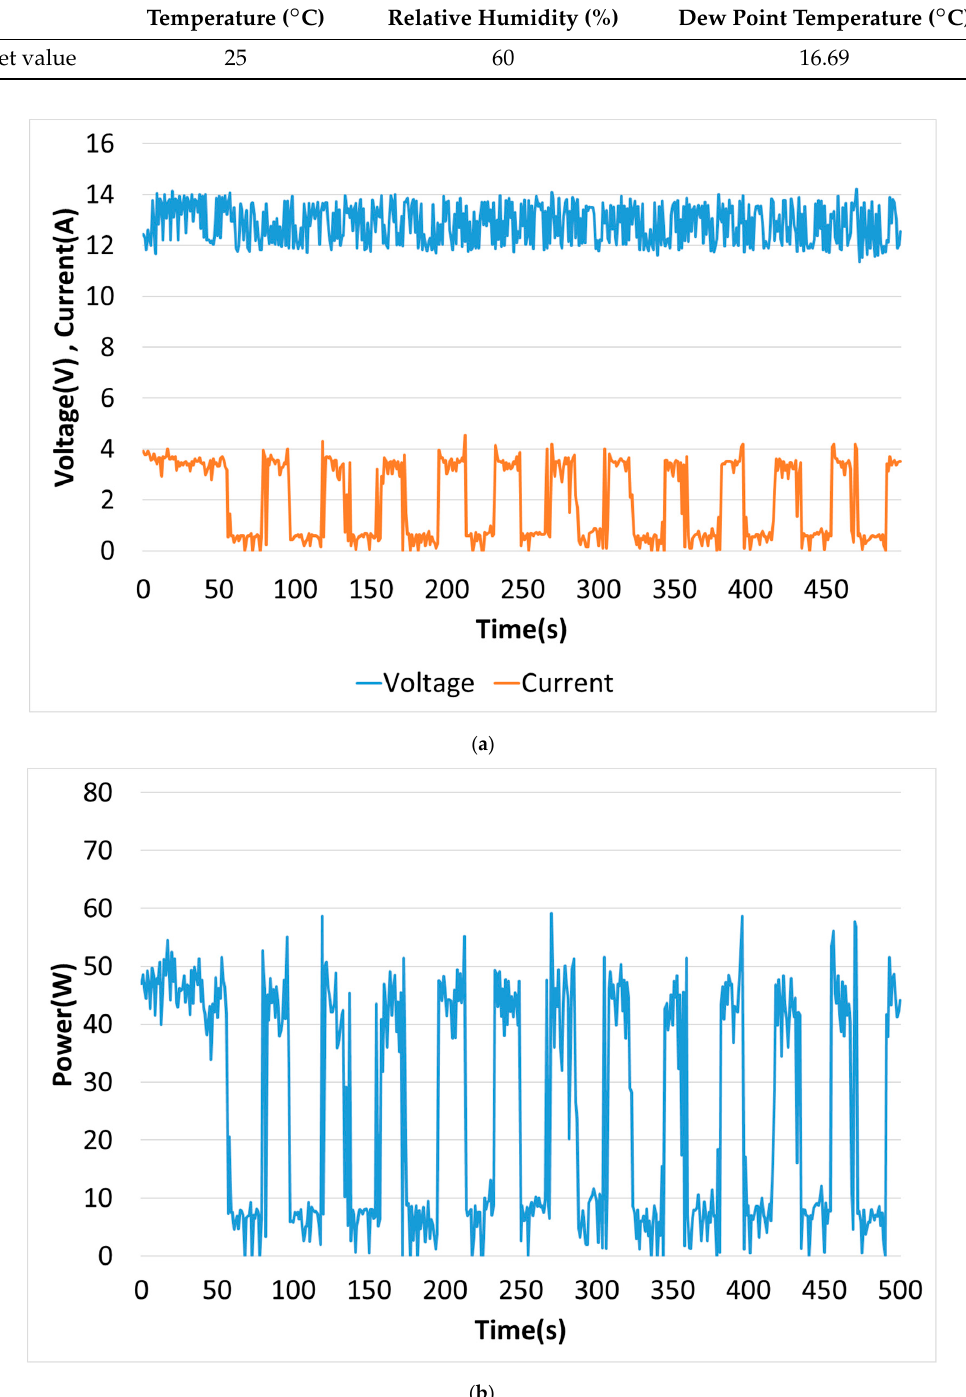
Figure 12. Voltage, Current, and Power of PI controller. ( a ) Voltage and Current. ( b ) Power.